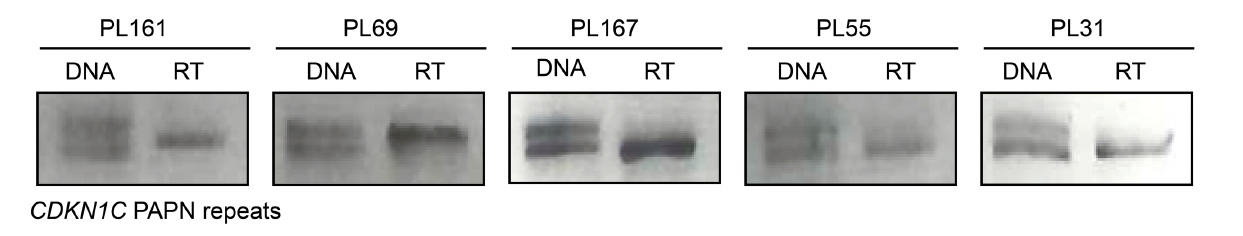
Frontiers in Genetics |